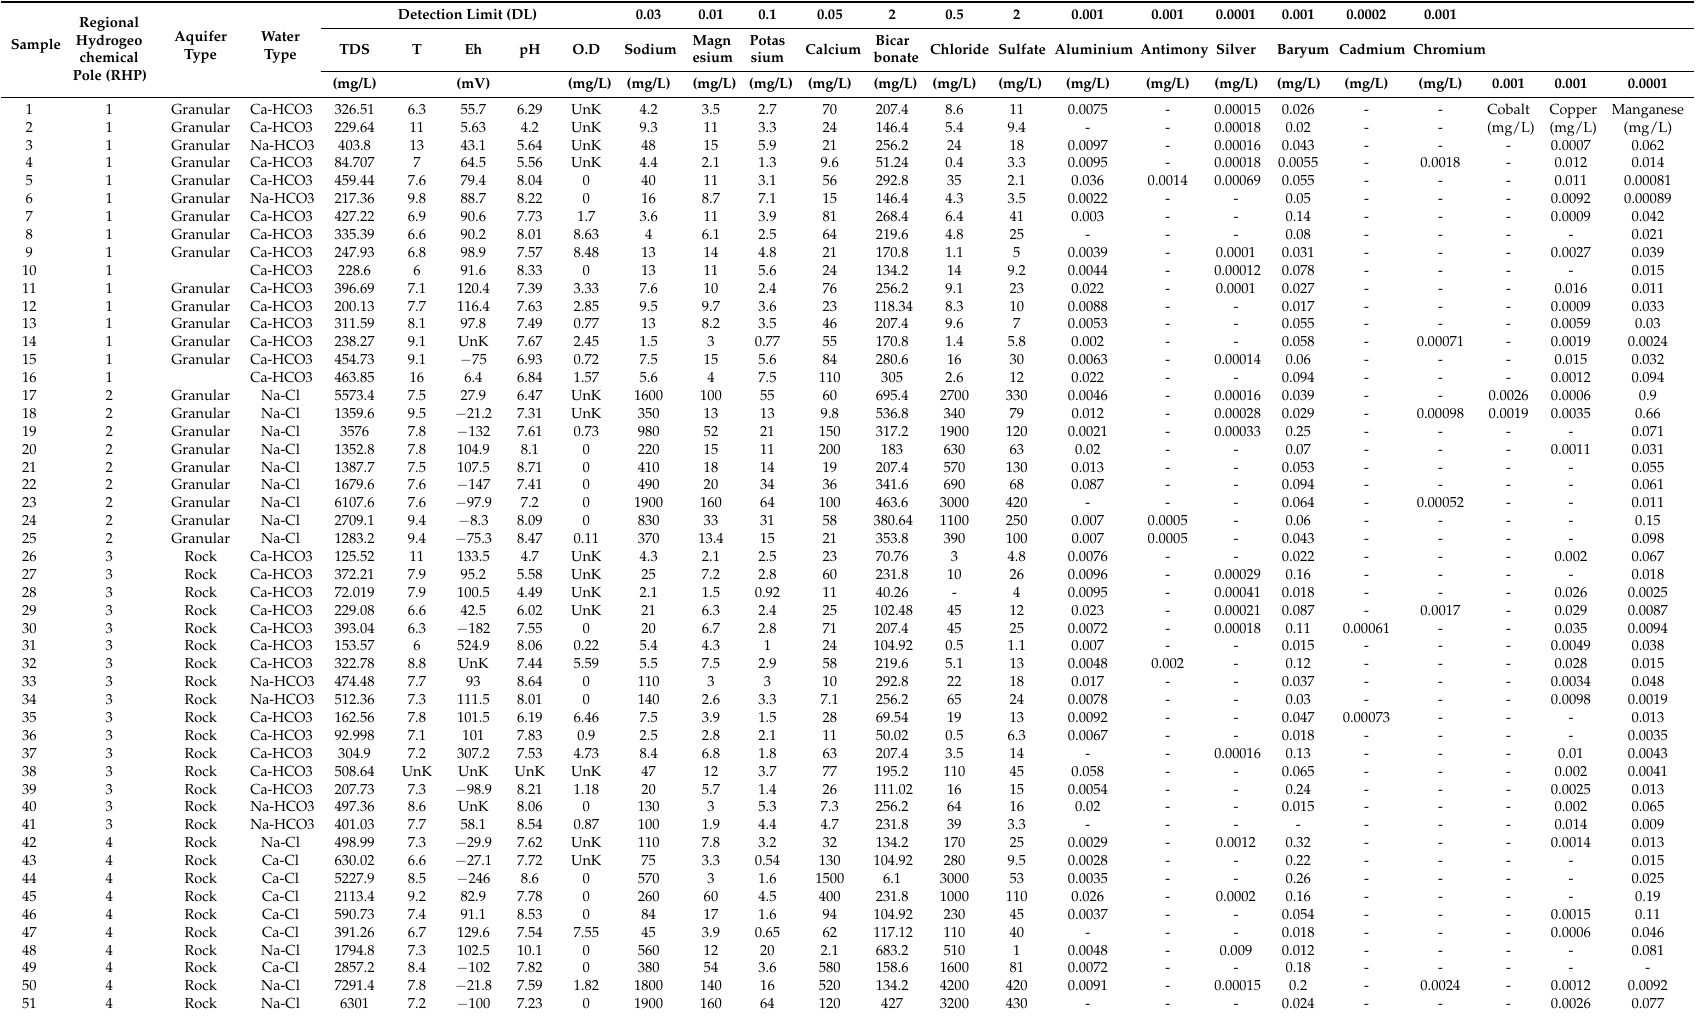
Table 4. Physicochemical data for the Cluster (51 samples of the